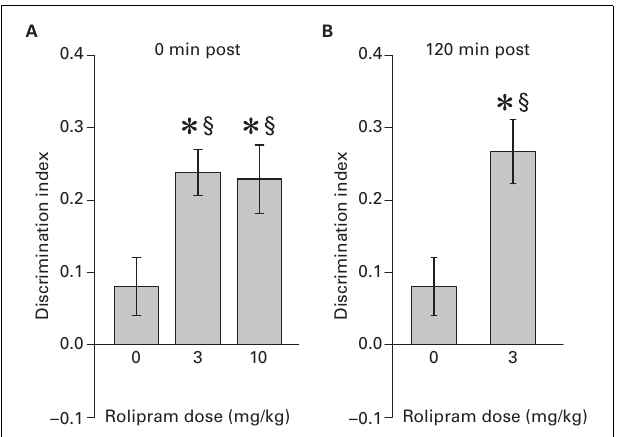
FIGURE 1 | (A) Discrimination index (mean ± SEM) as a function of stimulus paired with test context measured 24 or 96 h post-training (*vs CHOC, p < 0.01; # vs 24 h, p < 0.05; § vs 0, p < 0.0001); (B) Discrimination index (mean ± SEM) as a function of feeding state before behavioral testing